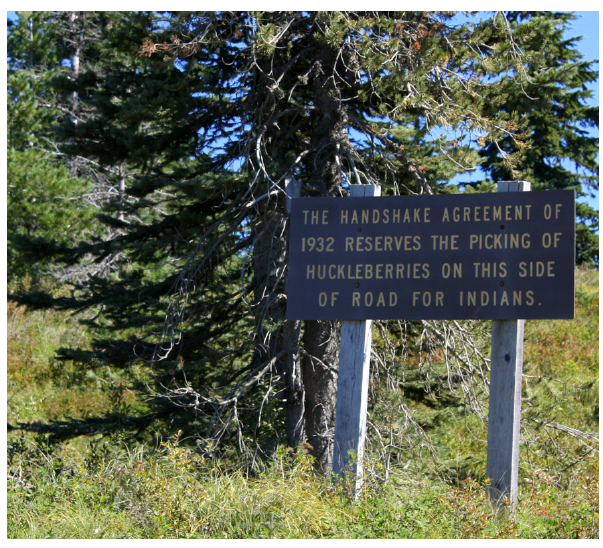
Fig. 4. A sign marks the boundary of an exclusive gathering area set aside decades ago under the “Handshake Agreement” in a part of the Indian Heaven Wilderness, Gifford Pinchot National Forest, Washington, USA. Photo courtesy of Leslie